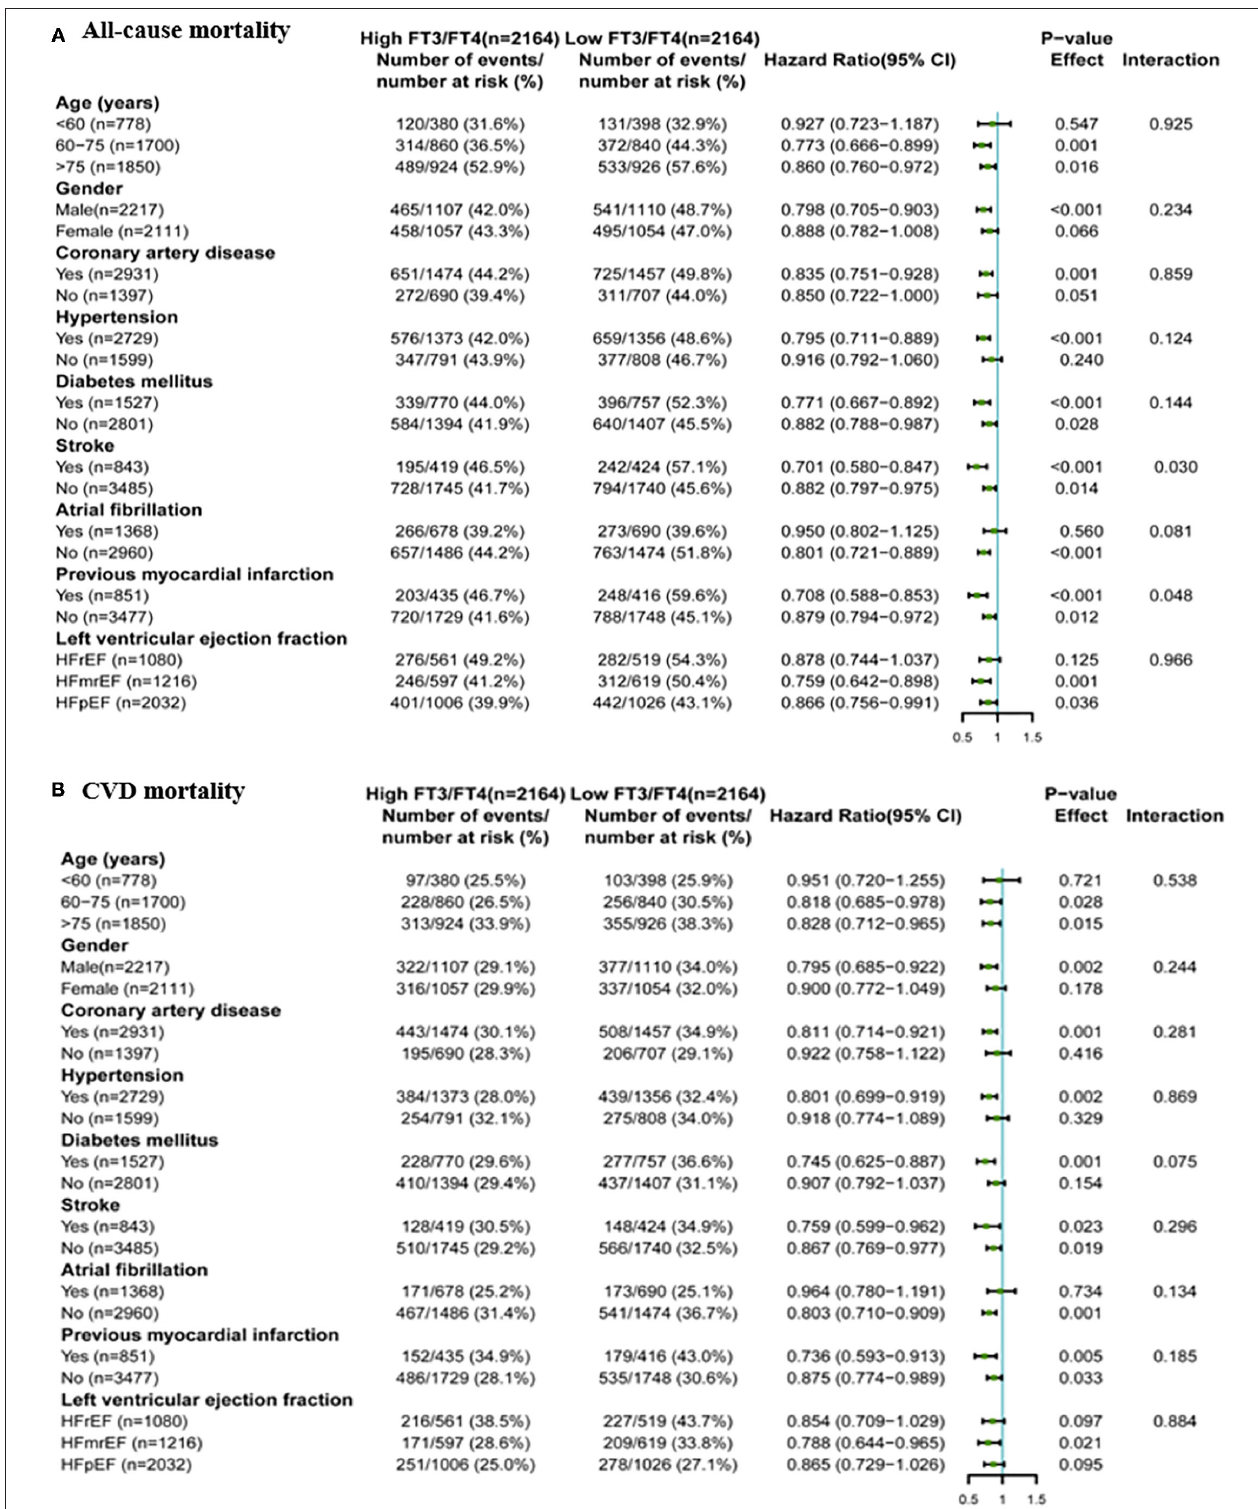
FIGURE 3 | Association of high and low FT3/FT4 ratio with all-cause/CV mortality in subgroups of propensity score-matched patients, (A) all-cause mortality, (B) CV mortality.